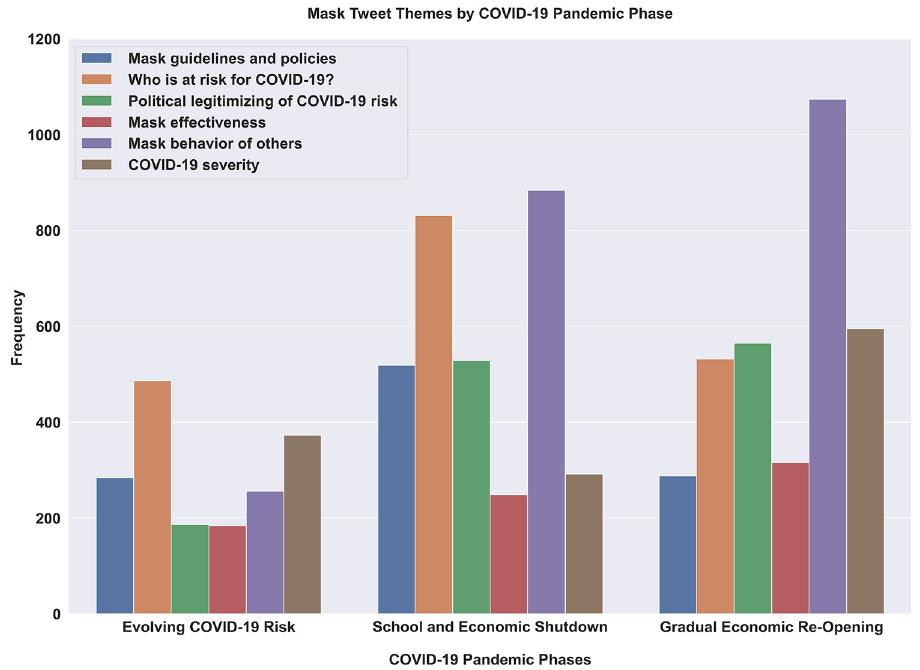
Fig 3. Frequency of the six COVID-19 risk perception themes for the three major phases of the early pandemic response between January 24 and July 7, 2020. The three phases are: Evolving COVID-19 risk (1/24/20–04/03/20), School and economic shutdown (04/04/20–05/25/20), and Gradual Economic Reopening (05/26/20–07/07/20).